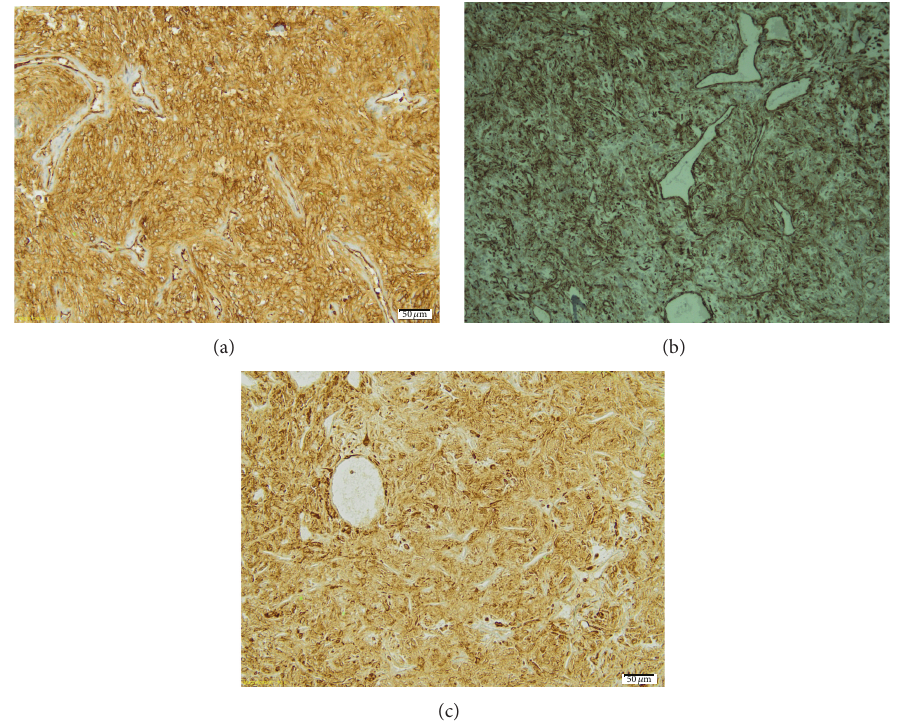
Figure 4: (a) A diffuse and strong cytoplasmic positivity of tumor cells is observed at this medium power magnification for CD34. (b) Vimentin immunohistochemical staining. (c) Strong cytoplasmic positivity for Bcl-2 is readily apparent.